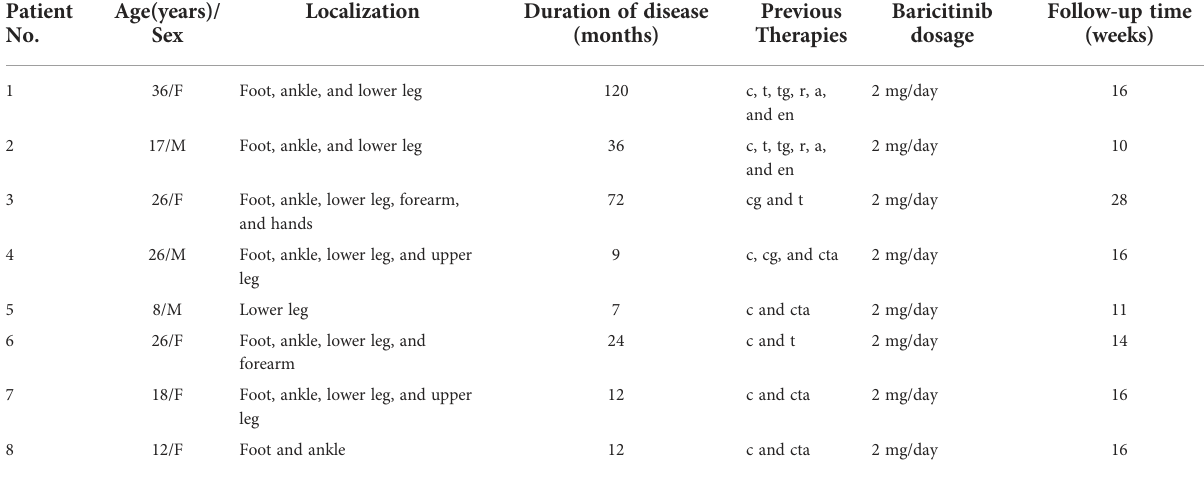
TABLE 1 Characteristics of patients treated with baricitinib for livedoid vasculopathy. Patient